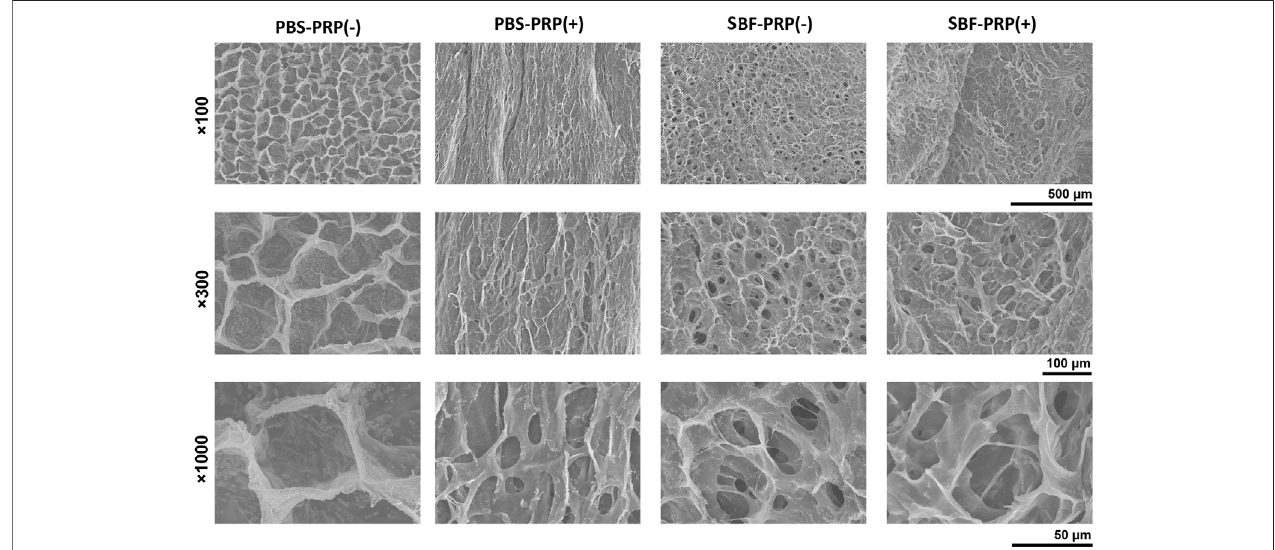
FIGURE 2 | Surface topography and their local magni fi cation of IPN M-ALG/PEG hydrogels observed by